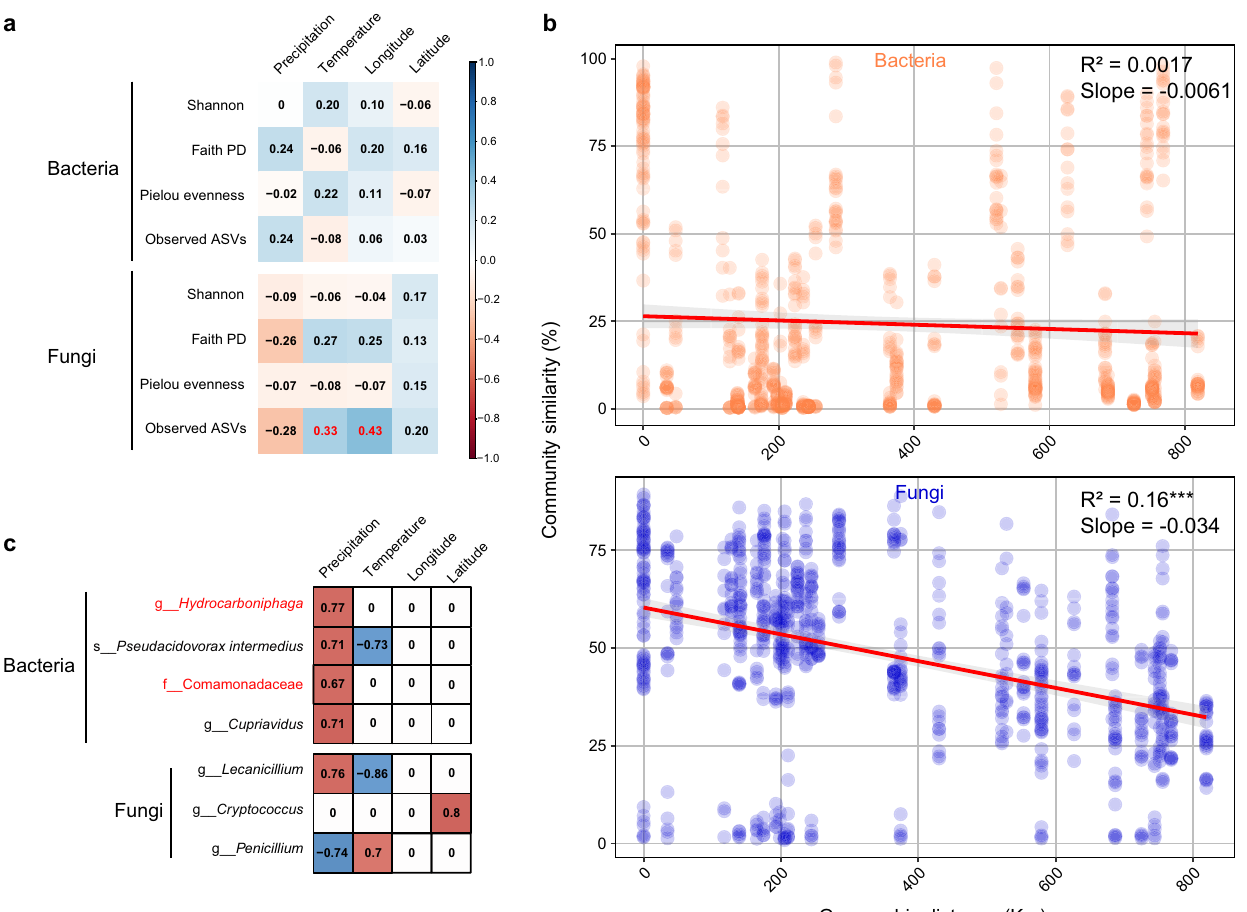
Fig. 5 Correlations between core microbial abundance with environmental abiotic factors among fi eld strains of Nilaparvata lugens . a Heatmap of correlations between different α -diversity indexes and environmental factors. The background color indicates the strength of the correlation ( r ) and whether it is negative (red) or positive (blue). All the correlations were shown but only red numbers represent signi fi cant correlation ( P < 0.05). b Distance – decay curves of similarity for symbionts communities. Red lines denote linear regression. Asterisks represent the signi fi cance of correlation (*** P < 0.0001). c Correlations are based on Spearman correlation coef fi cients; blue means positive correlation, and red means negative correlation. No signi fi cant correlation ( P > 0.05) was shown in white color. Microbial labels in red color were key microbial in Fig.